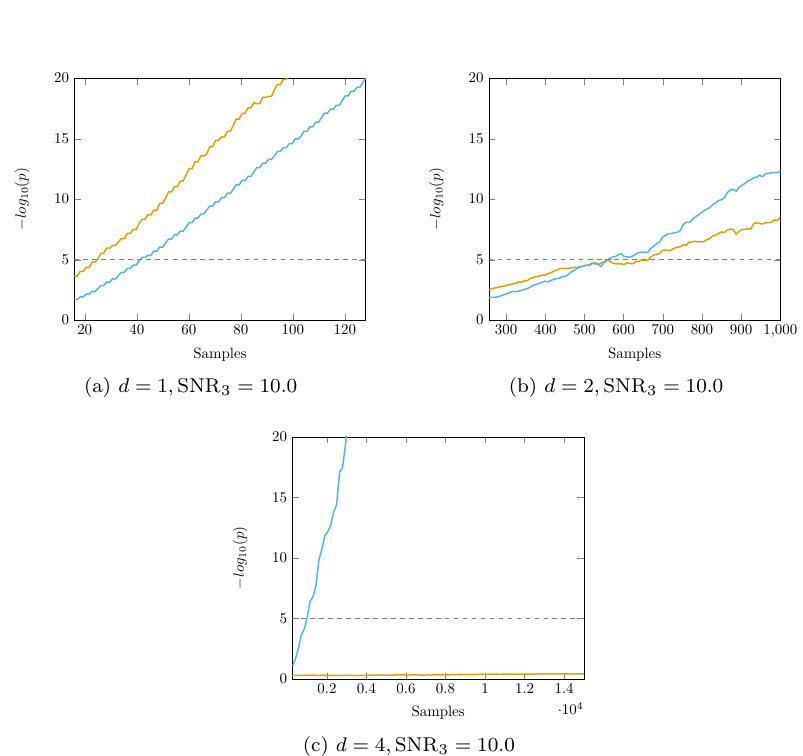
Figure 12: Performance of the (orange) t -test and (blue) χ 2 -test for simulated univariate 1st-, 2nd-, and 4th-order leakage with SNR 3 = 10 .